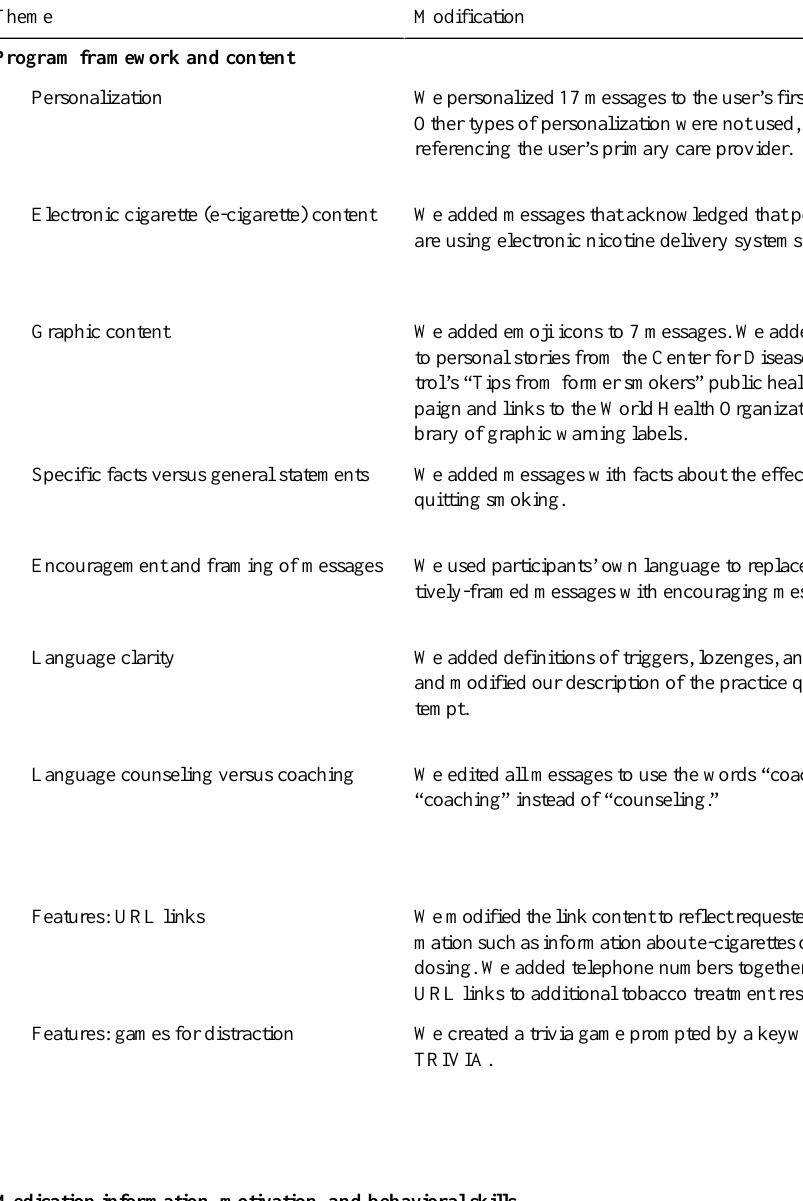
Table 2. Description of text message modifications and examples by theme.